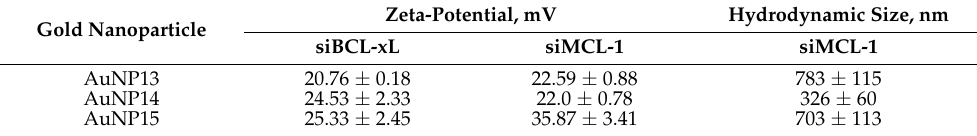
Table 4. Zeta-potential and hydrodynamic size of AuNP-siBCL-xL complexes on plateau [27]. Gold